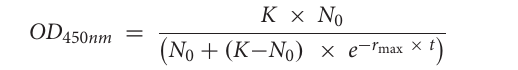
( Figure 2 , species and species ∗ treatment effect, Table 1 ). In general, highest r max were observed under blue light whereas green light resulted in species’ lowest r max ( Figure 2 ). Post-hoc tests revealed that phytoplankton r max did not differ significantly between the blue and blue-green light treatments ( Figure 2A and Table 1 ), however, r max under green vs. blue light as well as r max under green vs. blue-green were significantly different ( Figure 2A and Table 1 ). K was overall highest affected by green light ( Figure 2B , significant treatment effects and treatment comparison, Table 1 ) but did not differ between blue and blue- green